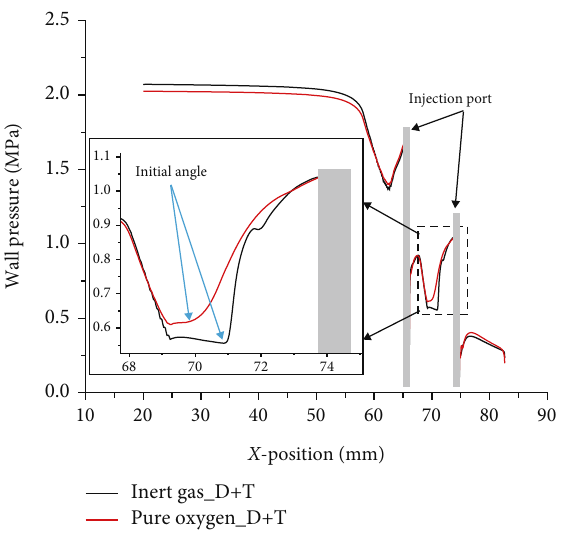
Figure 19: Pressure of upper wall (injected in the divergence section and